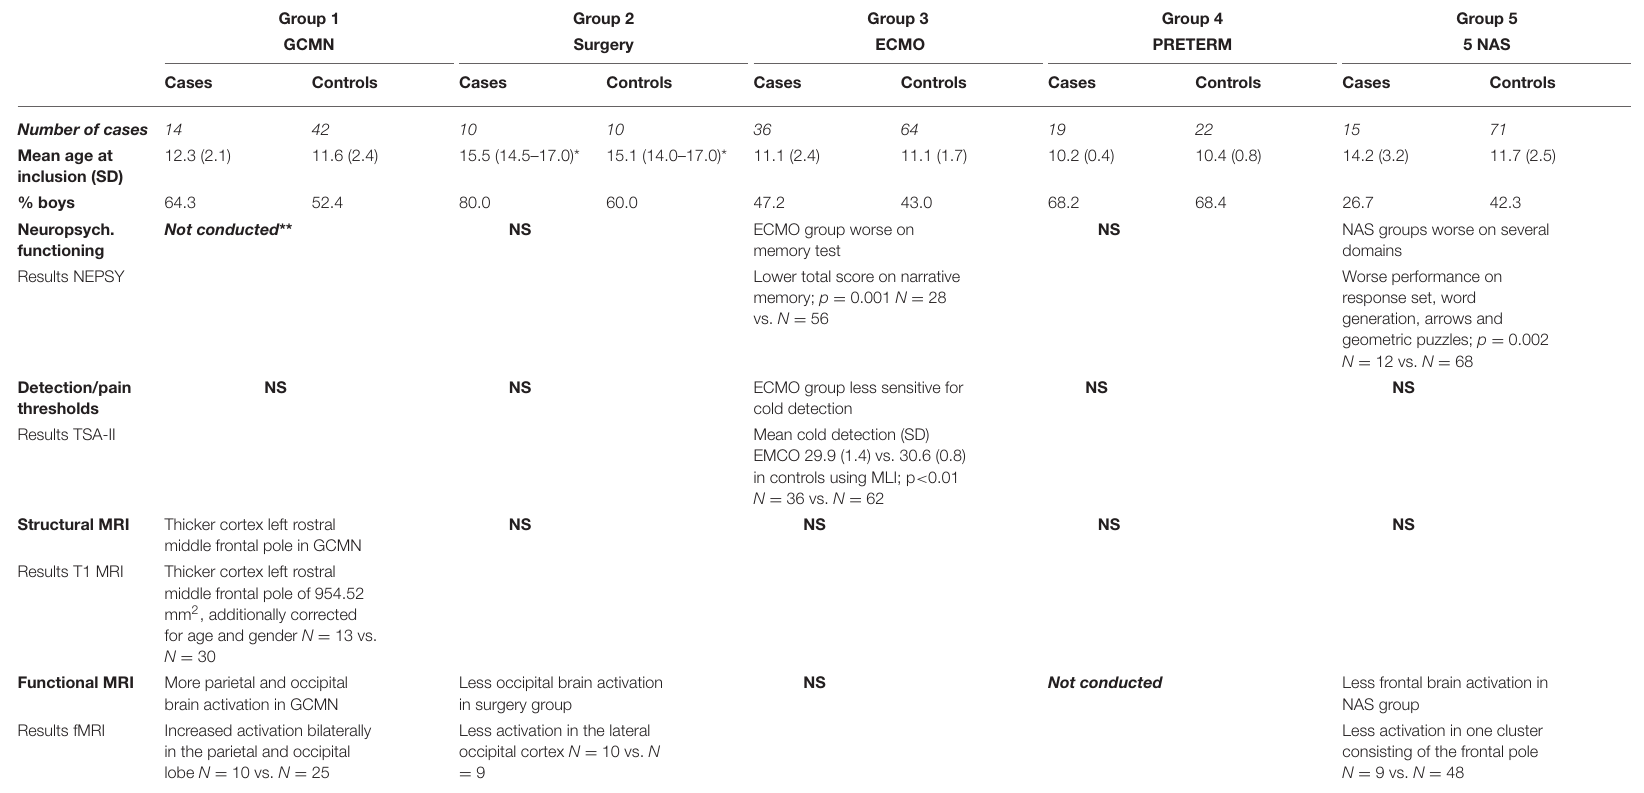
TABLE 3 | Overview of background characteristics and statistically significant results per group. Group 1